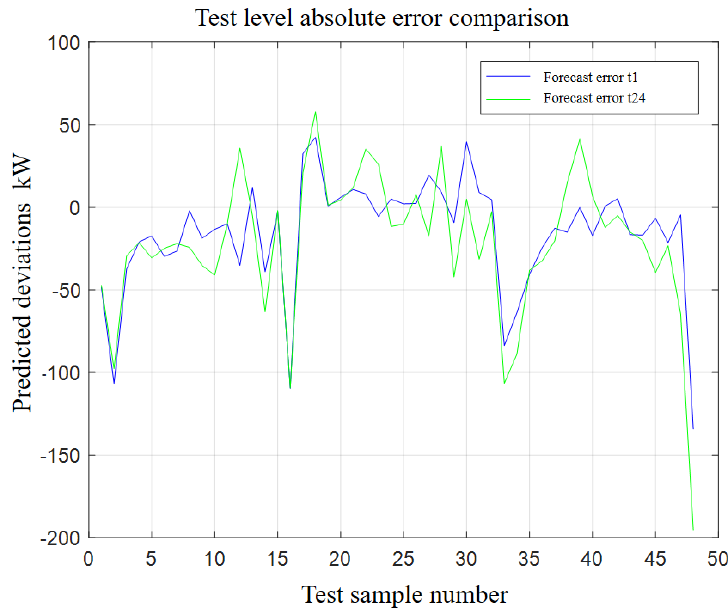
Figure 43. The comparison of the absolute error of fitting the test set.